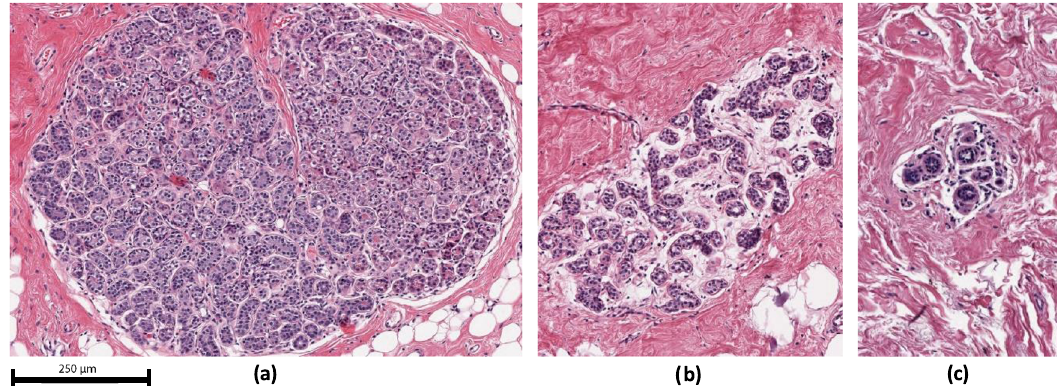
Fig. 4 Involution examples: Examples of different levels of involution. From left to right: no involution ( a ), partial involution ( b ), complete involution ( c